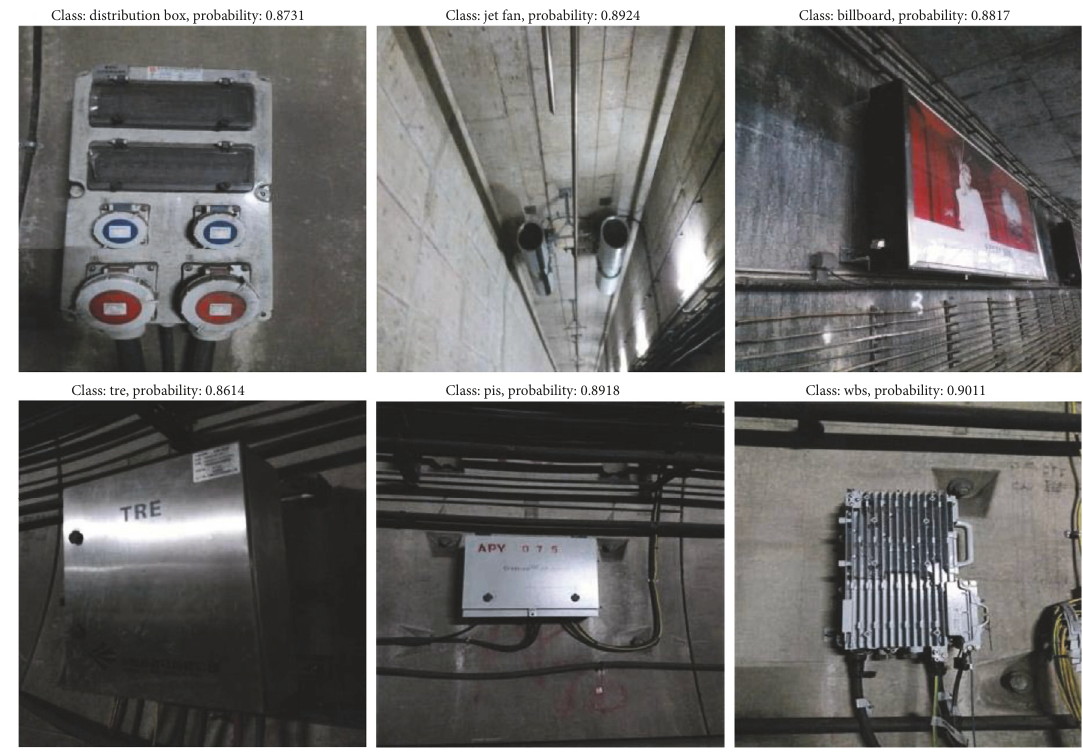
Figure 10: A few results by the CNN.